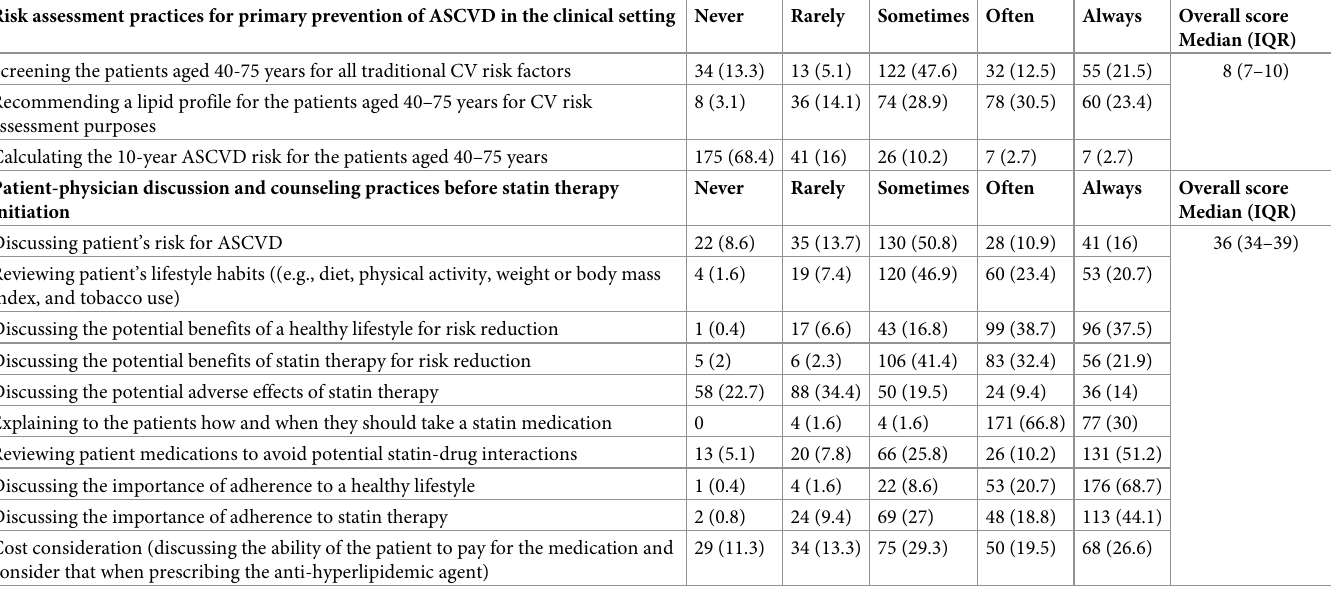
Table 7. Physicians’ practices for risk assessment and counseling before statin therapy